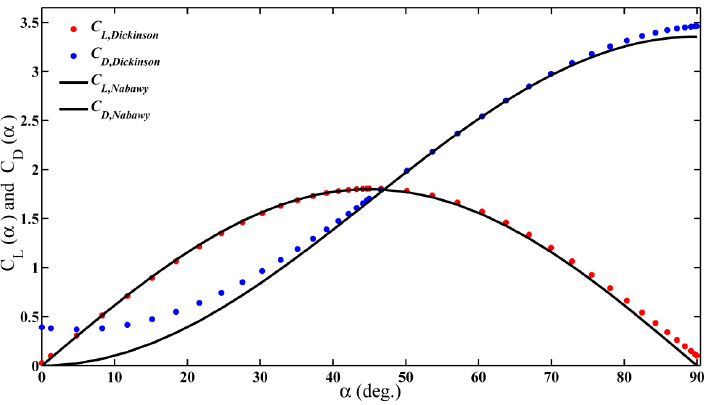
Figure 5. Translational circulations lift and drag coefficients.